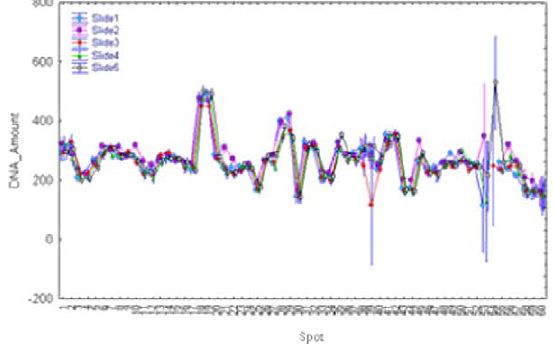
Fig. 4. Five different slides showing the variation of mean nuclear size per dot per slide.